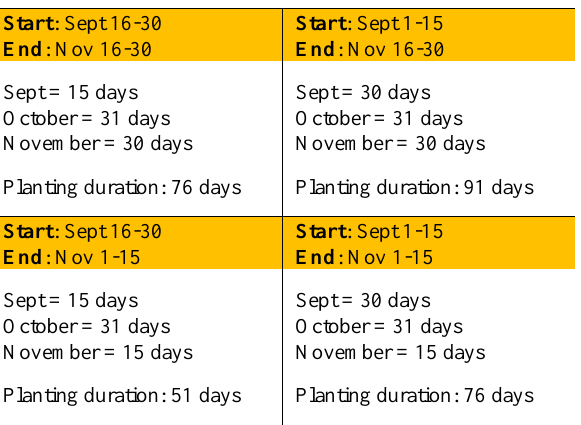
Figure 3. Sample computation of planting